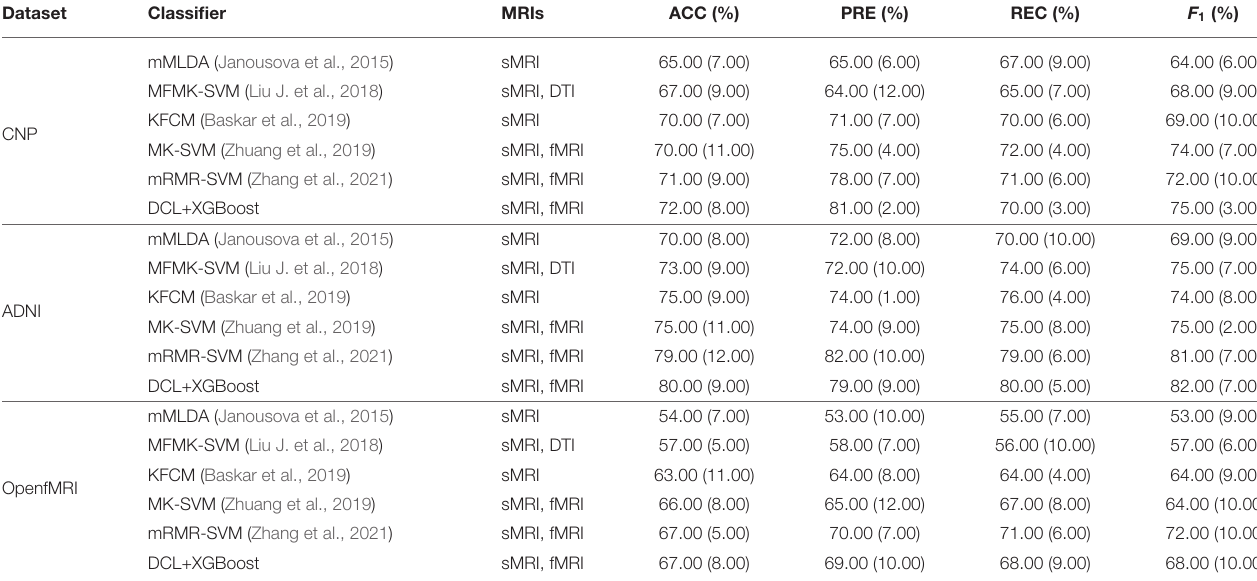
TABLE 7 | Comparison results with other methods on tree datasets.